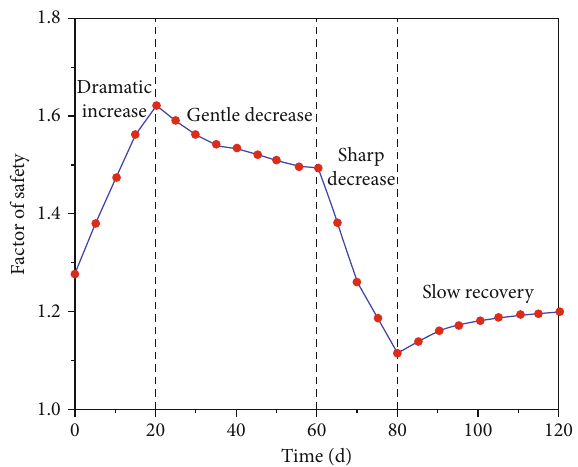
Figure 11: The safety coe ffi cient variation rule versus the